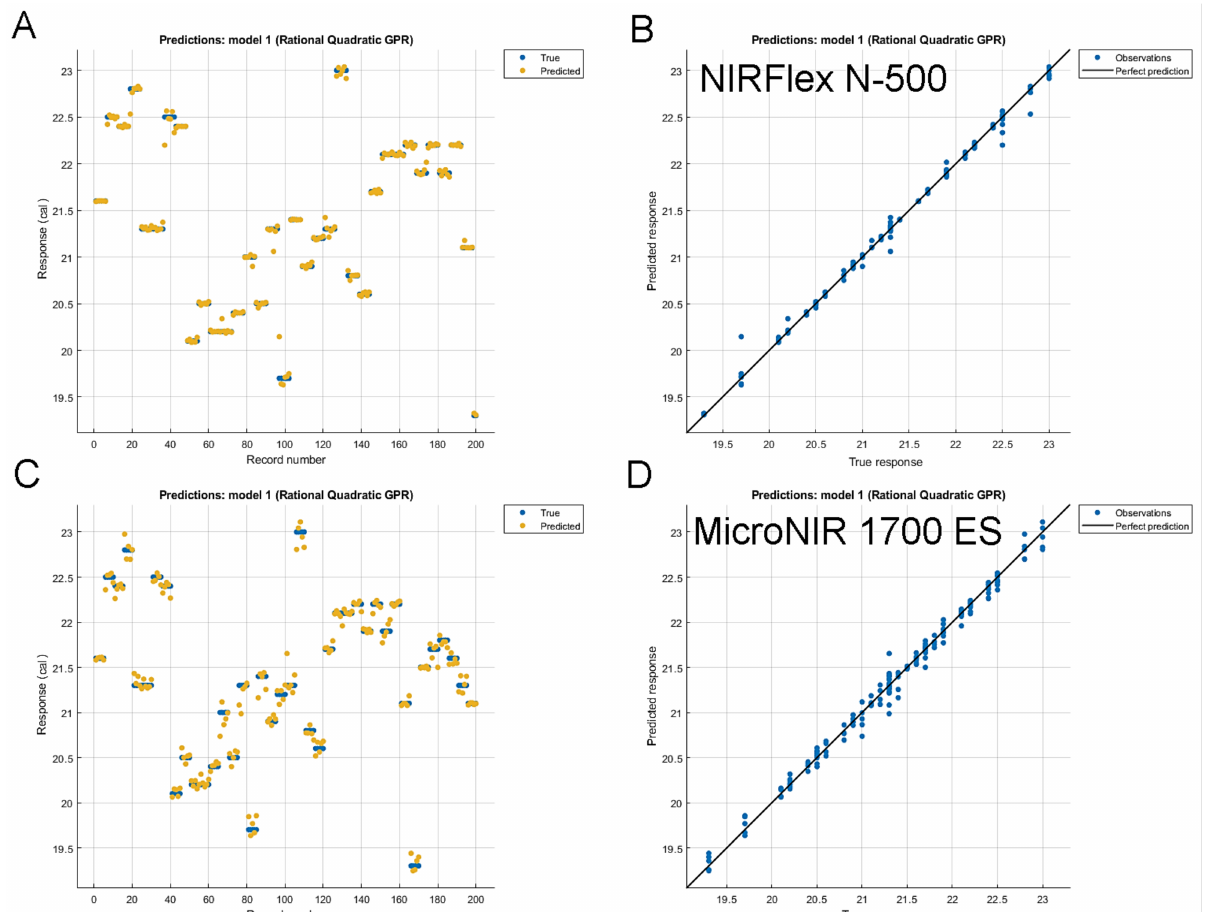
Figure 3. The fit of the GPR model to the calibration set of milled samples for ( A , B ) benchtop and ( C , D ) miniaturized MicroNIR 1700 ES spectrometer. ( A , C ): response plot; ( B , D ): predicted vs. true response